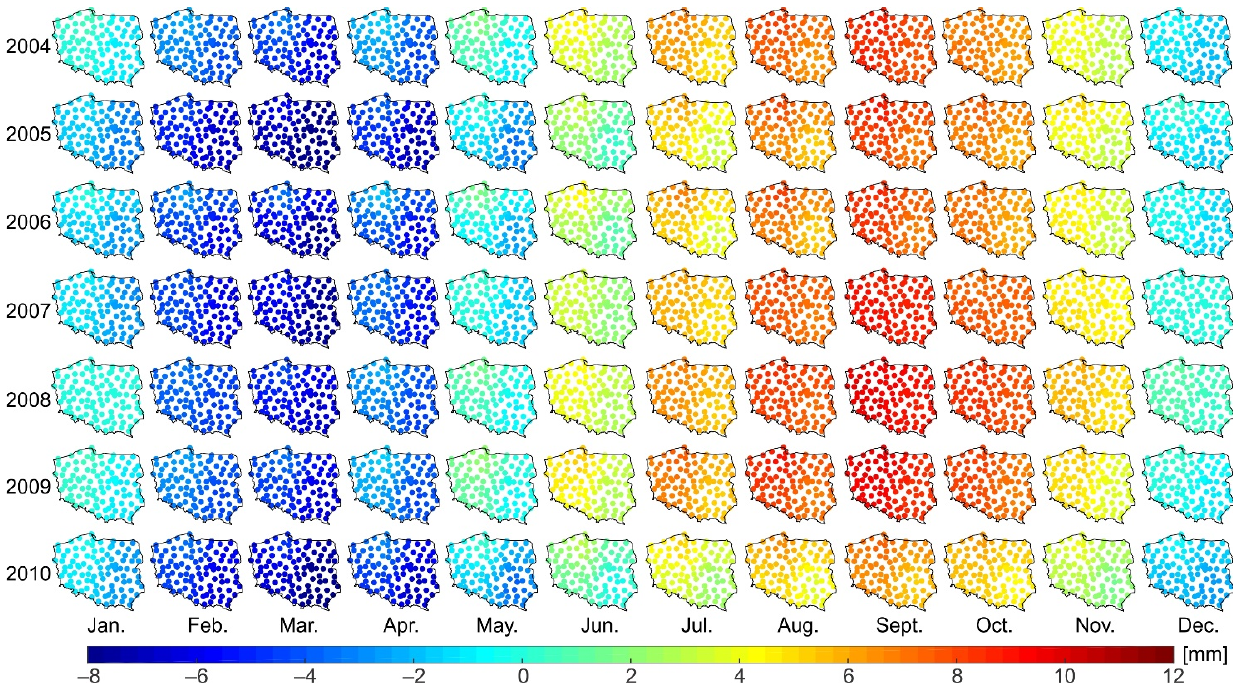
Figure 15. Temporal variations of orthometric/normal heights estimated at the ASG ‒ EPOS network sites.